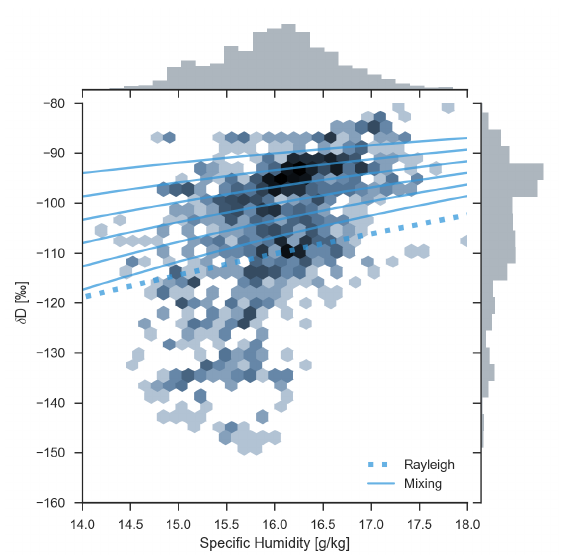
Figure 4. Distribution of δ D relative to specific humidity ( q ). Darker hexagons in the central axis indicate greater joint densities. The dotted line traces the Rayleigh distillation curve (Equation (4)) starting from δ D = − 80% and q = 25gkg − 1 . The solid lines indicate mixing lines (Equation (5)) between a ‘moist’ air mass with δ D = − 80% and q = 25gkg − 1 and a ‘dry’ air mass with q = 9.3gkg − 1 and δ D values of (from top to bottom) − 110%, − 120%, − 130%, − 140%, − 150%, and − 160%. Settings for the theoretical models are based on outputs from an isotope-enabled global model [42] for water vapor at different vertical levels near the observation